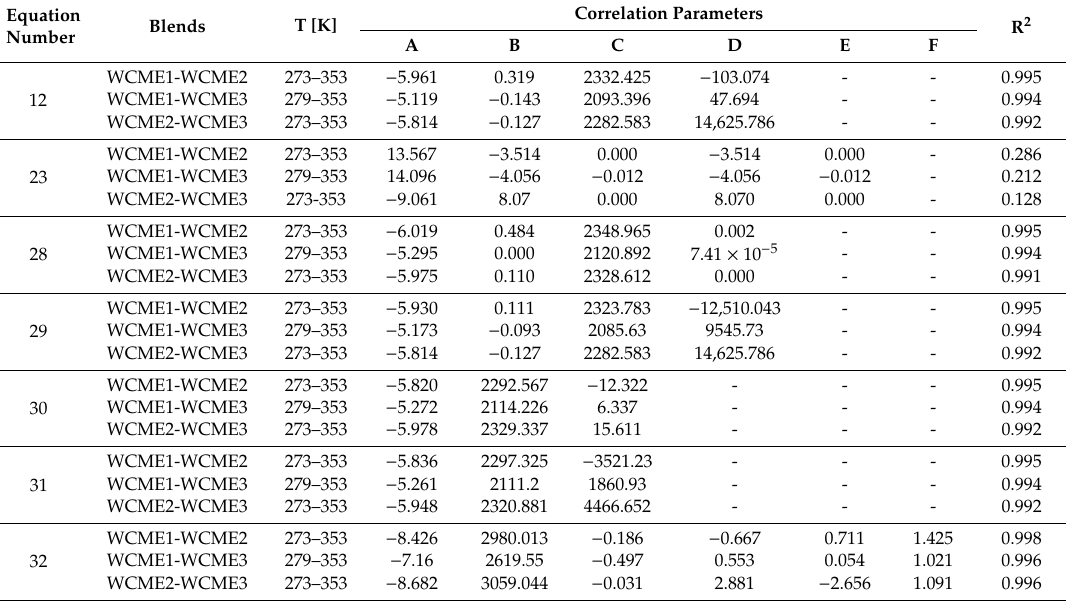
Table 9. Kinematic viscosity-volume fraction-temperature correlations for di ff erent biodiesel blends; correlation parameters and R 2